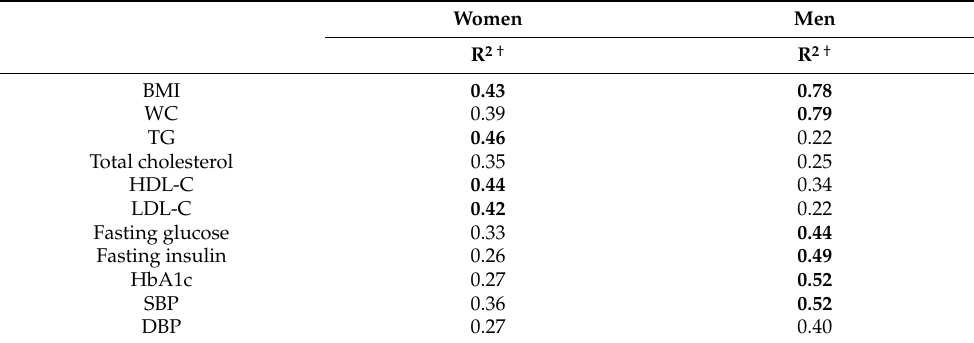
Table 2. Pearson correlation coefficients of determination (R 2 ) for the clinical outcomes according to the ridge regression. R 2 > 0.4 are in